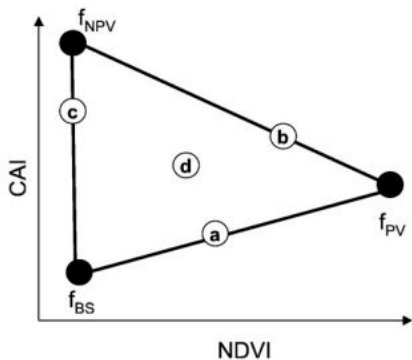
Figure A1. Response space between NDVI and cellulose absorption index (CAI) [11]. CAI is calculated using Sentinel-2 bands 11 and 12, and it can be used to distinguish dry vegetation because reflectance in those wavelengths is absent in soil and green vegetation. The response space between NDVI and CAI can be used to estimate the fractions of photosynthetic vegetation (PV), non-photosynthetic (NPV) and bare soil (BS) within a pixel. When the pure spectra of PV, NPV and BS are known, the reflectance spectra of mixed pixels (such as point d) will be shown inside the triangle and can be compared for fractional cover